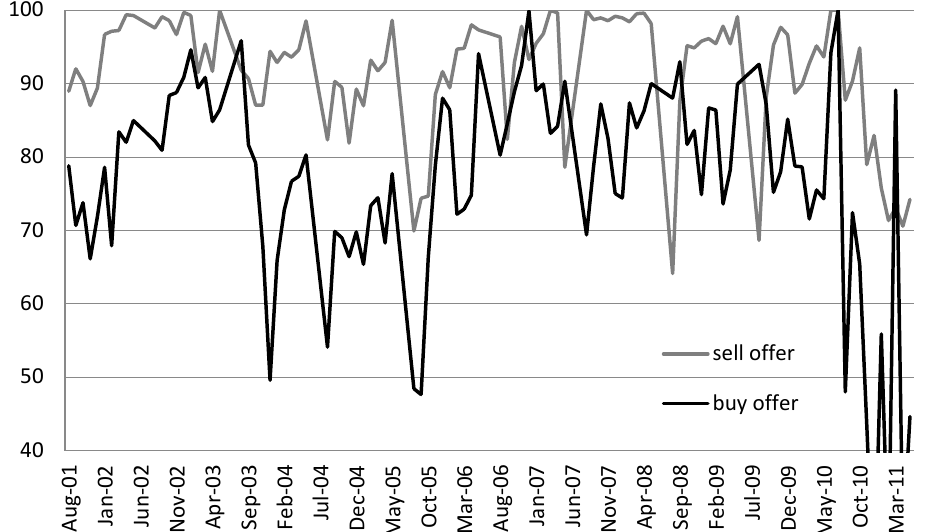
Figure 1. Water allocation price clustering at whole dollar amounts (all